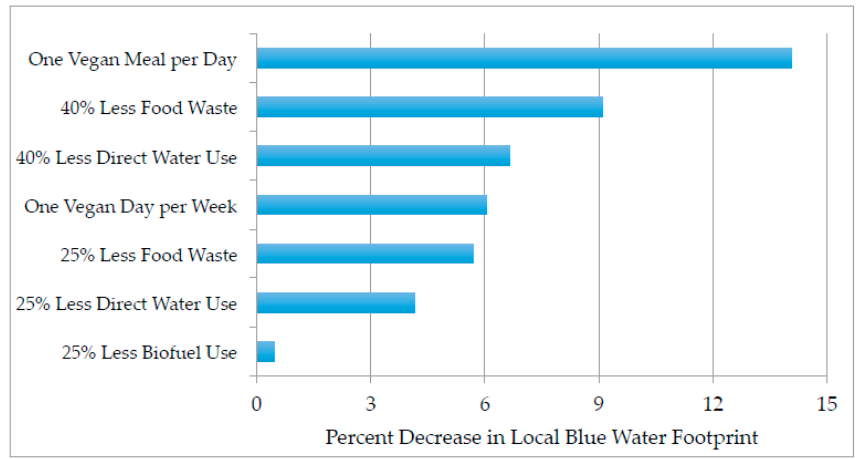
Figure 3. Percent decrease in California’s local blue water footprint as a function of potential water ‐ saving alternatives.